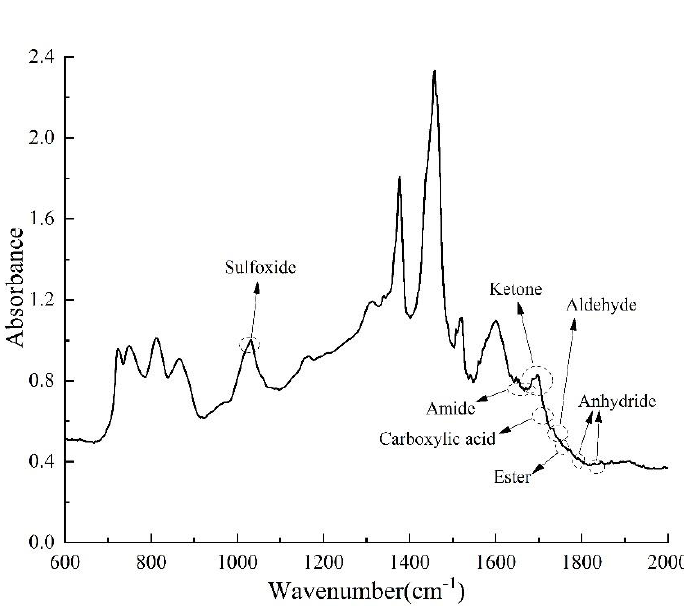
Figure 4. The positions of seven groups in the FTIR spectrum of aged asphalt.